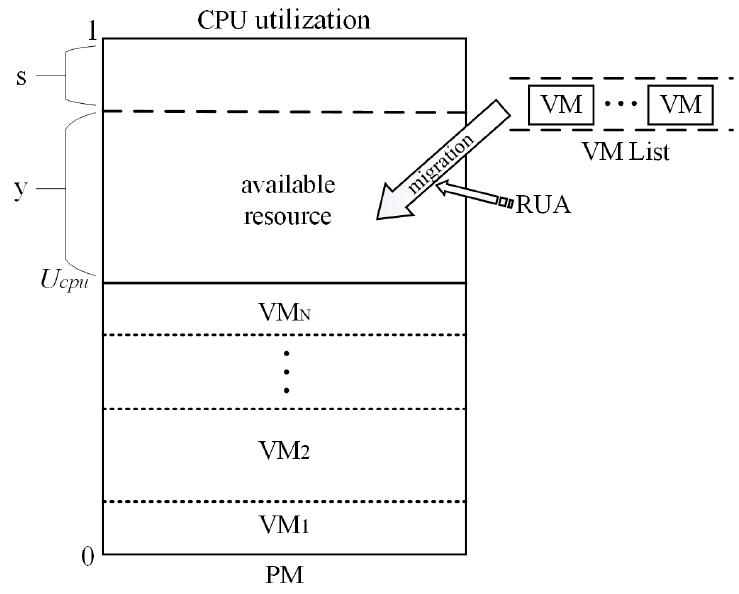
Figure 3. CPU utilization model of the physical machine